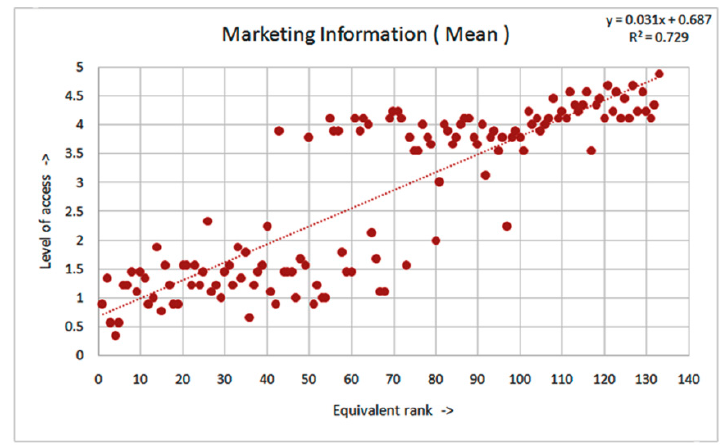
Figure 5. Level of access of marketing information (mean) vs. equivalent ICT rank.